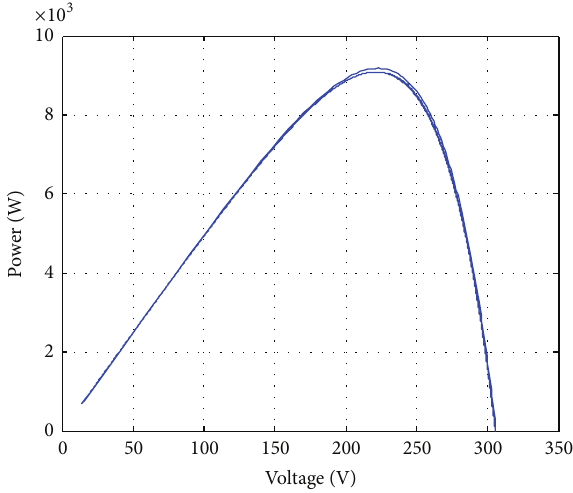
Figure 14: PV power-voltage